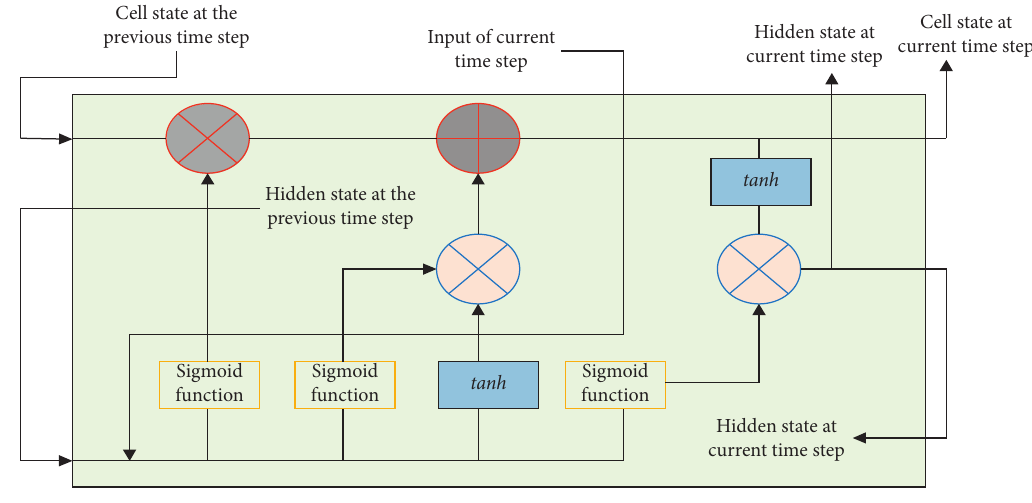
Figure 2: LSTM network